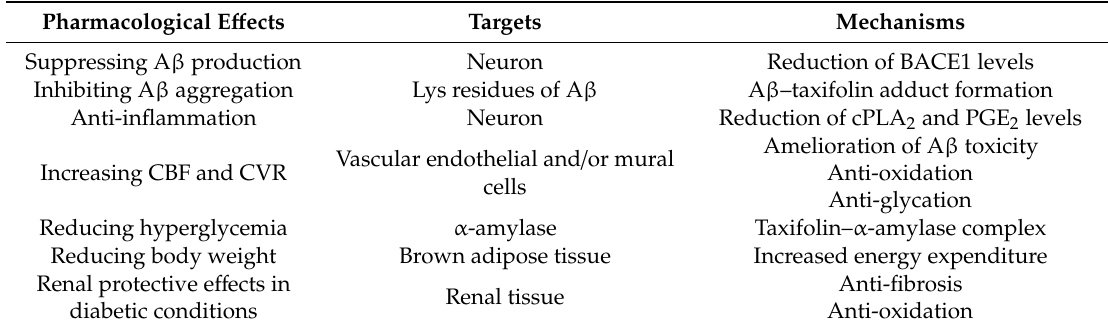
Table 1. Favorable effects of taxifolin on AD and CAA.